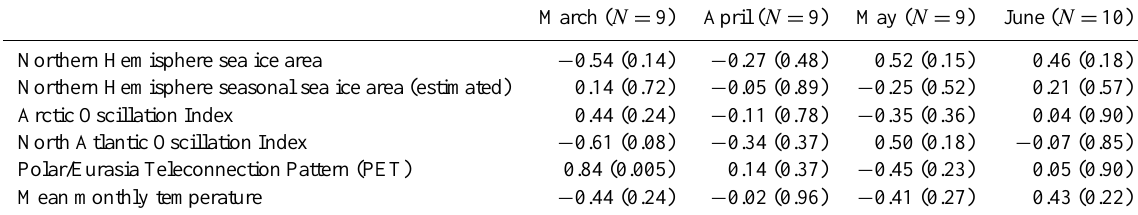
Table 1. Pearson’s correlation coefficients ( R ), and statistical significance level ( p ), expressed as R (p) , for monthly integrated atmospheric mercury depletion event frequency ( F AMDE ) at Alert with monthly climate-related parameters. The number of months in the period 1995– 2007 with sufficient GEM data are reported as N